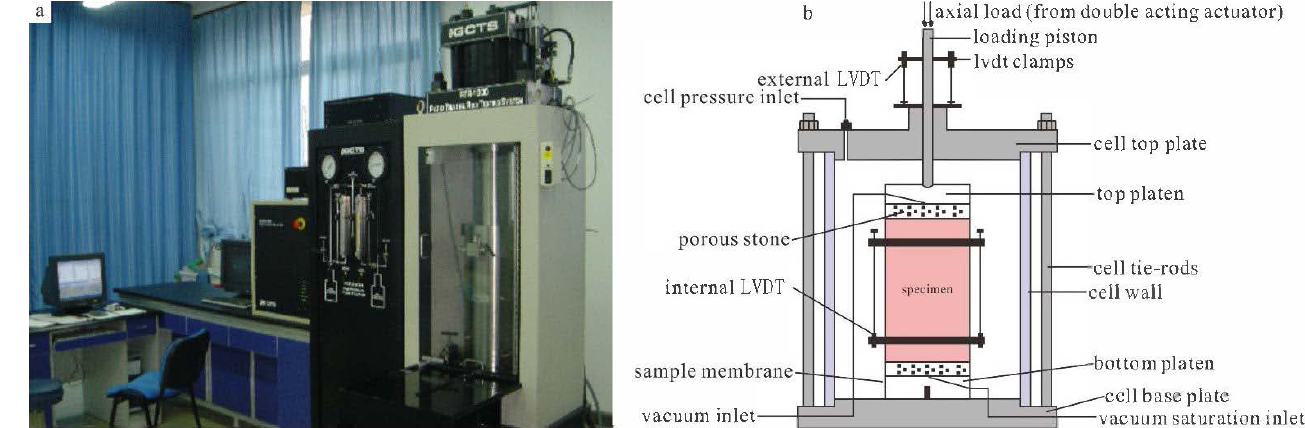
Figure 2. Triaxial stress test system ( a ) and the structure of the experiment instrument ( b ). The experimental device adopts the triaxial test in lateral isobaric mode (Photos of experimental equipment and schematic diagram of experimental devices are provided by the State Key Laboratory of Oil & Gas Reservoir Geology and Exploitation Engineering of Southwest Petroleum University).